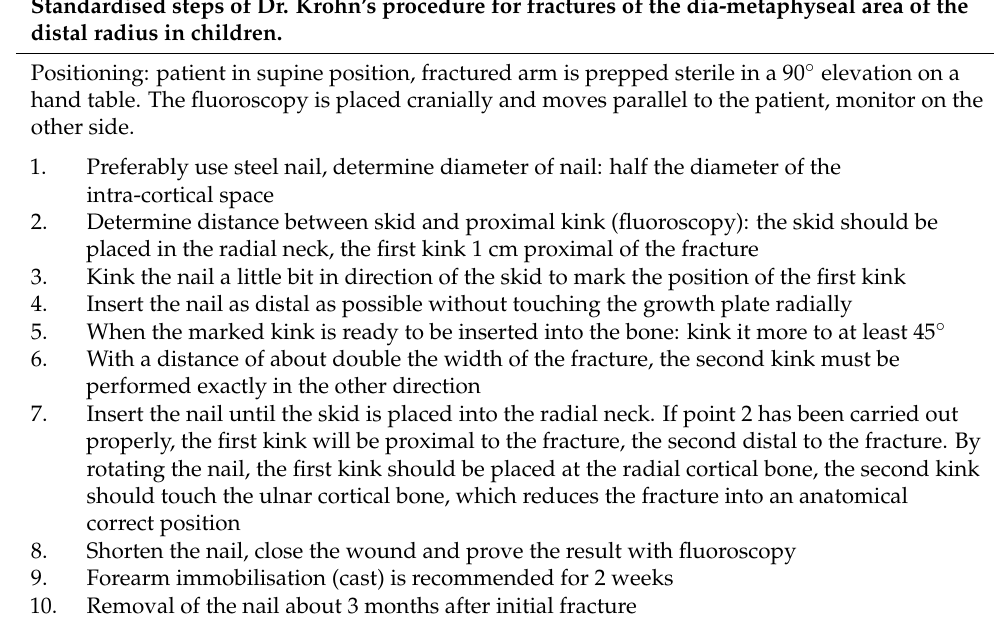
Table 1. Standardised surgical manual.